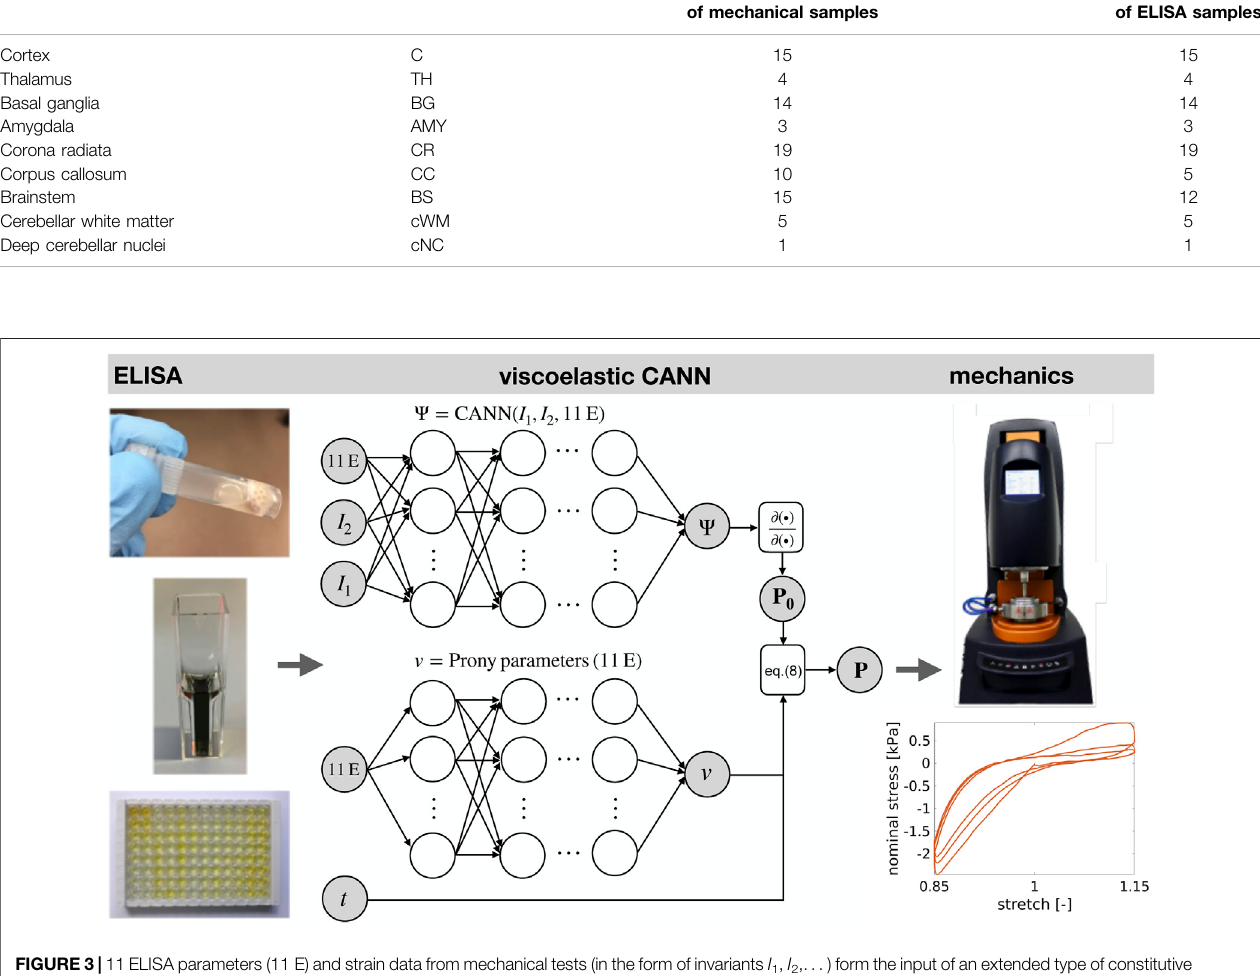
Frontiers in Bioengineering and Biotechnology |